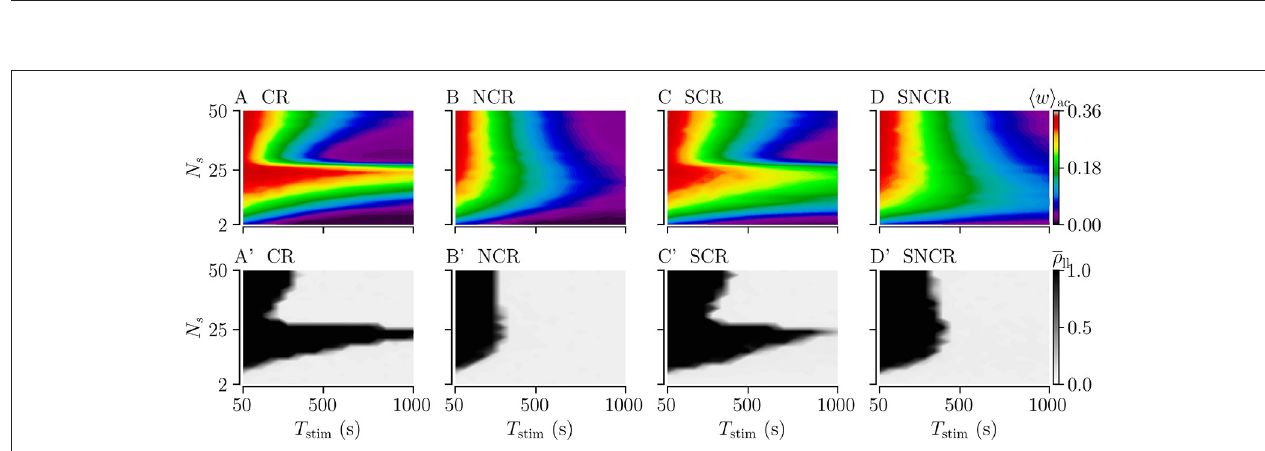
FIGURE 8 | Acute and long-lasting effects of stimulation for different stimulation durations. (A–D) acute mean synaptic weight, h w i ac , at the end of a stimulation period T stim for different numbers of stimulation sites N s . (A’–D’) Long-lasting desynchronization effects quantified by the Kuramoto order parameter, ρ ll , Equation (2), recorded 1,000 s after a stimulation period of duration T stim . Low values indicate desynchronized spiking activity and high values in-phase synchronization of neuronal spiking. Parameters: A stim = 0.1 and f CR = 12